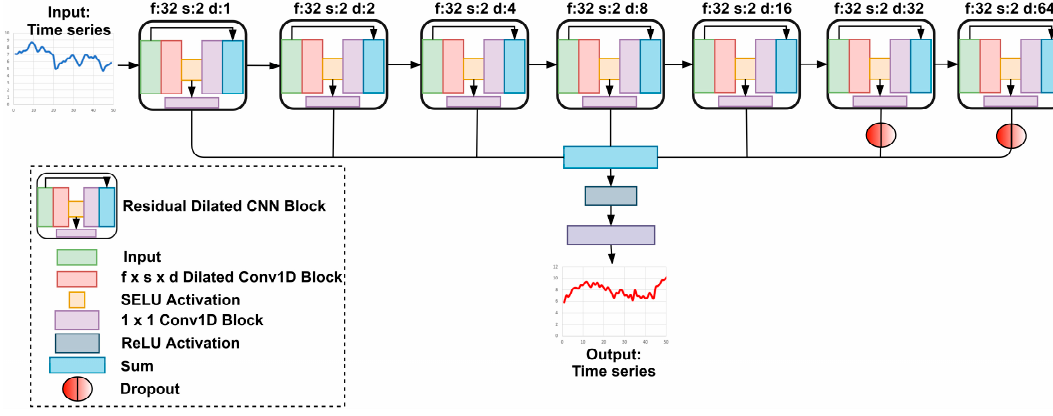
Figure 6. SeriesNet with residual blocks and skipped connections. Figure 6 . SeriesNet with residual blocks and skipped connections . Table 3. Residual block hyperparameters. Table 3. Residual block hyperparameters.